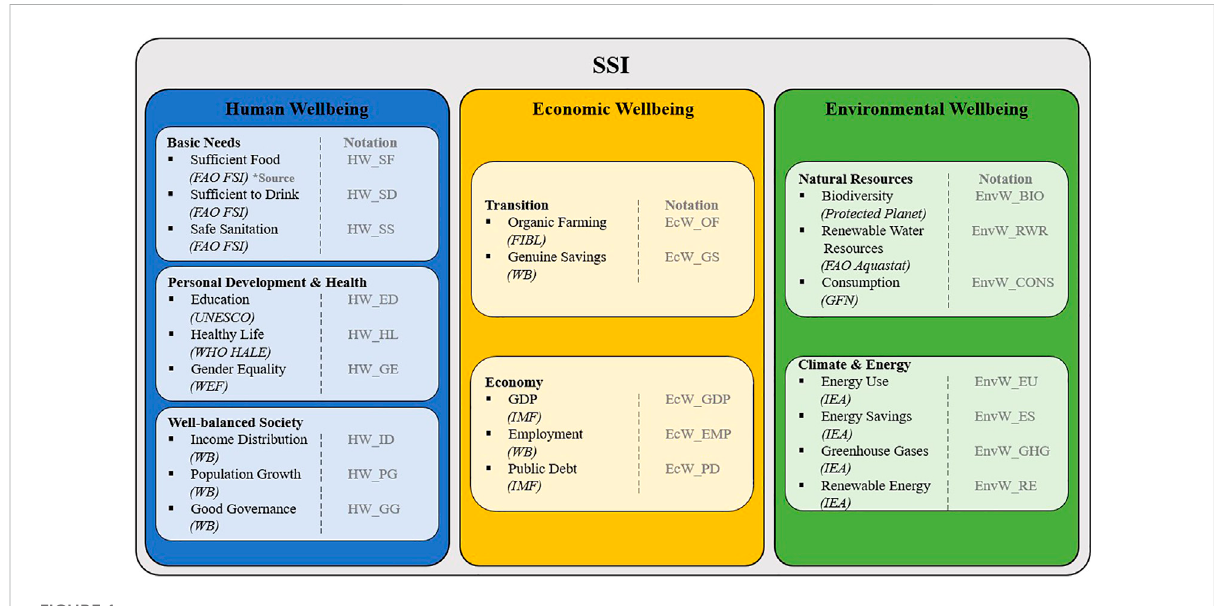
FIGURE 1 Sustainable Society Index (SSI) framework (Van De Kerk and Manuel,